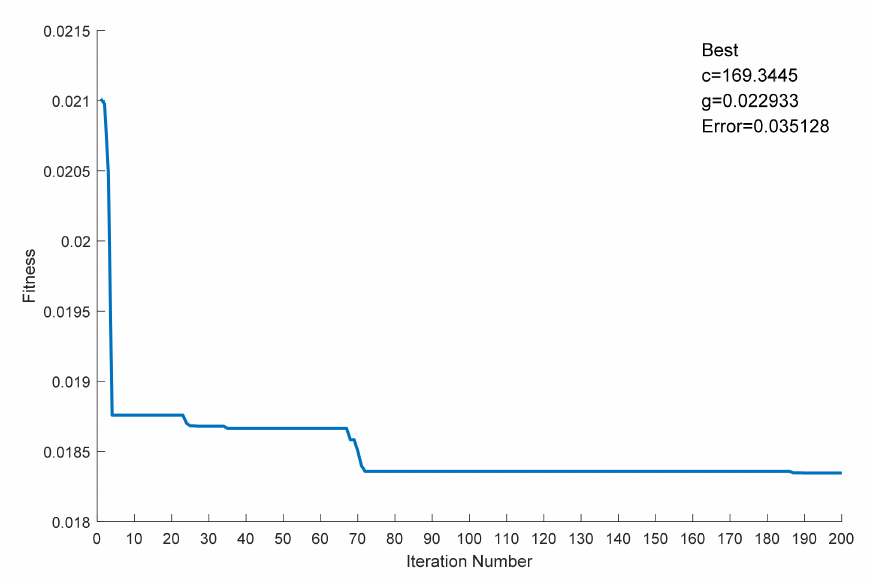
Figure 2. Gaussian kernel parameters